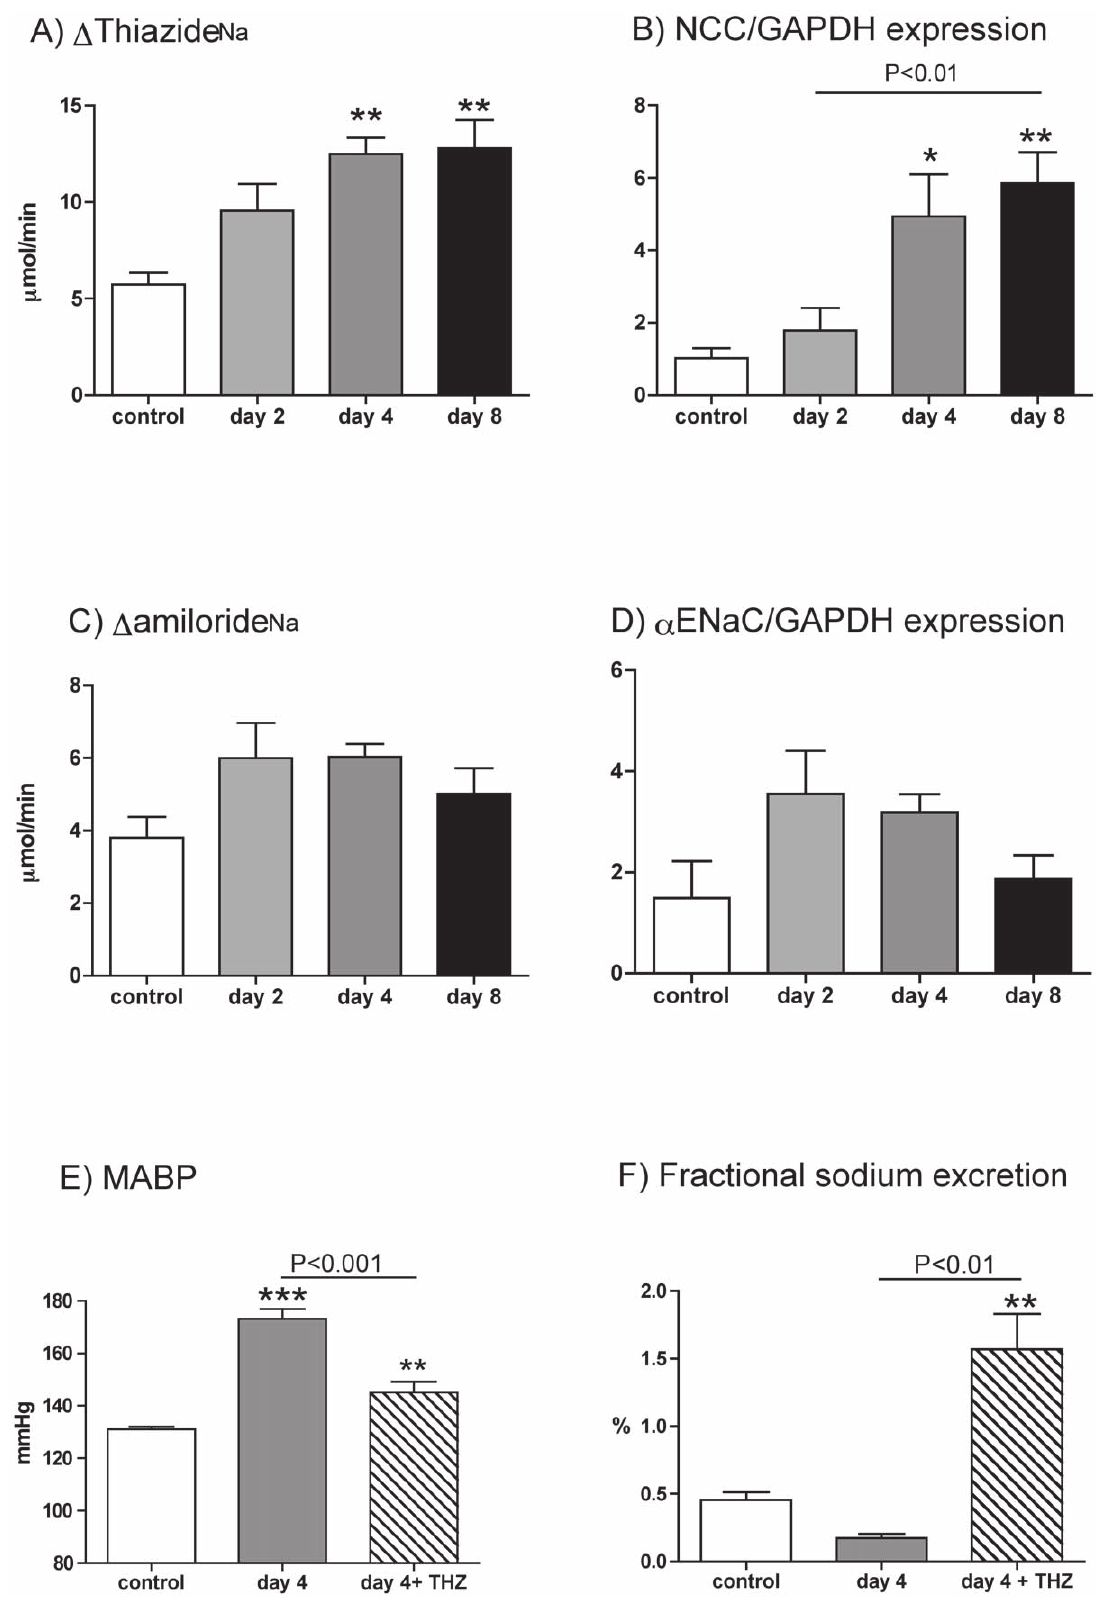
Figure 4. Sodium transport pathways in the aldosterone-sensitive distal nephron. A) hydrochlorthiazide-sensitive sodium reabsorption ( D thiazide Na ); B) the expression of the thiazide-sensitive co-transporter protein (NCC) in whole kidney extracts, normalized to that of GAPDH; C)